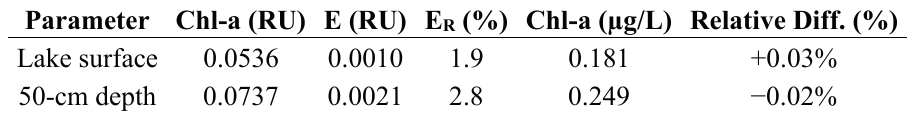
Table 3. Results of Albano Lake measurements achieved by the submersible spectrofluorometer.